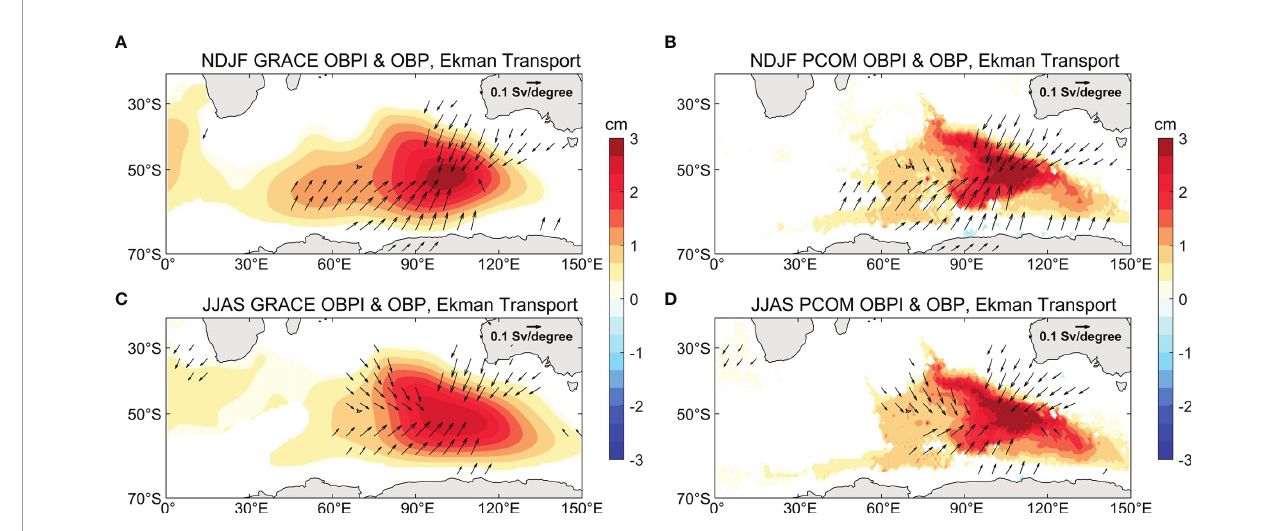
FIGURE 3 | Regression coef fi cients of OBP anomalies (color) and Ekman transports (vector) on the (A) normalized NDJF-averaged GRACE OBPI and (C) normalized JJAS-averaged GRACE OBPI. (B) and (D) are identical to (A) and (C) but on PCOM OBPI. Only anomalies signi fi cant at the 95% signi fi cance level are